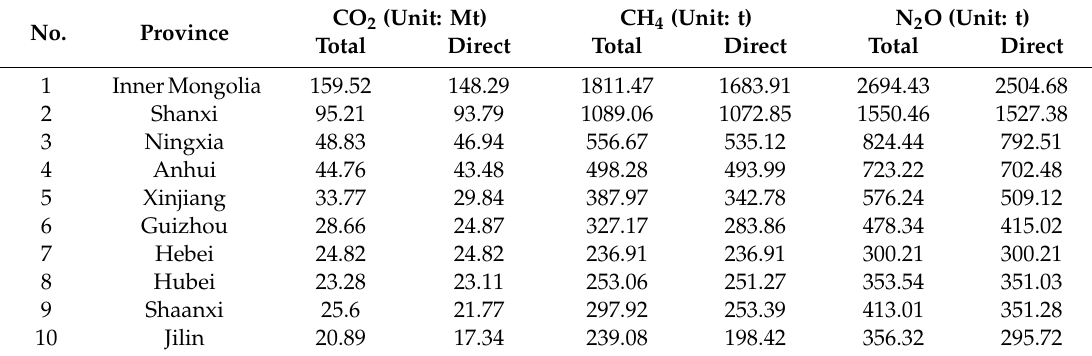
Table 2. Major emission imported